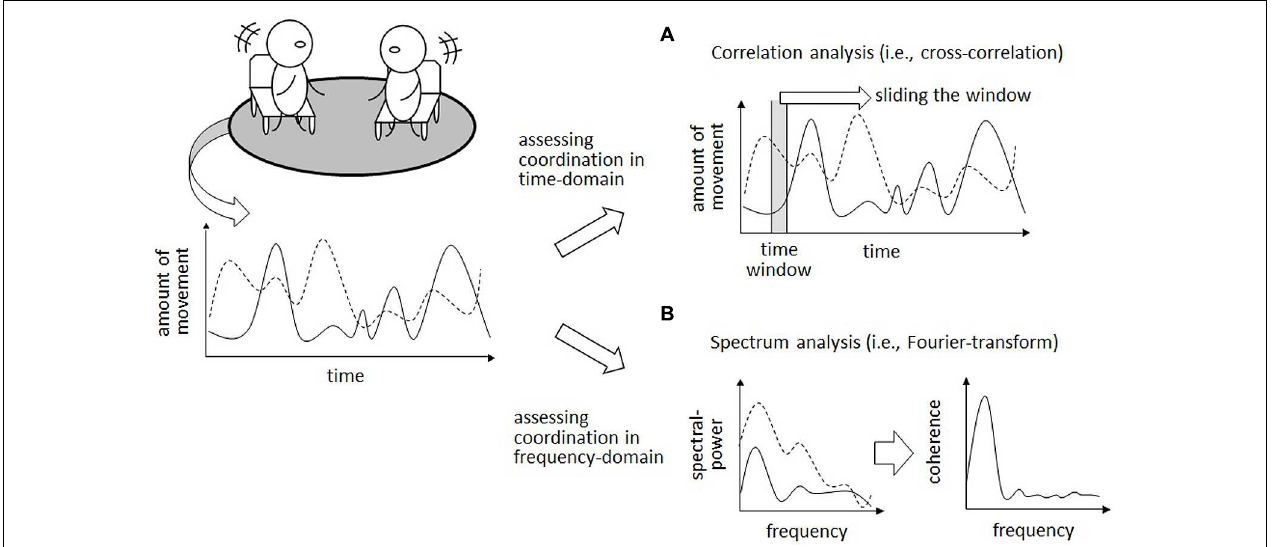
FIGURE 1 | Example of interpersonal coordination in time- and frequency- domains. This example illustrates the coordination of the amount of movement between two interactants in the time- (A) and frequency- (B) domains.